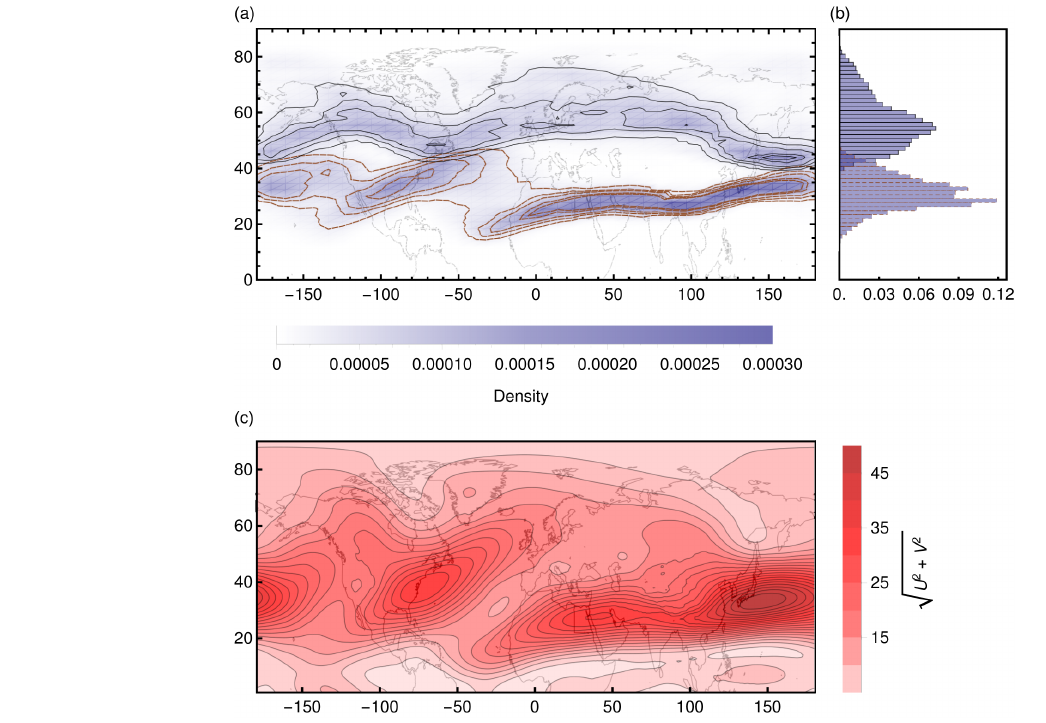
Figure 13. Probability analysis for winter months (DJF; compare with Fig.